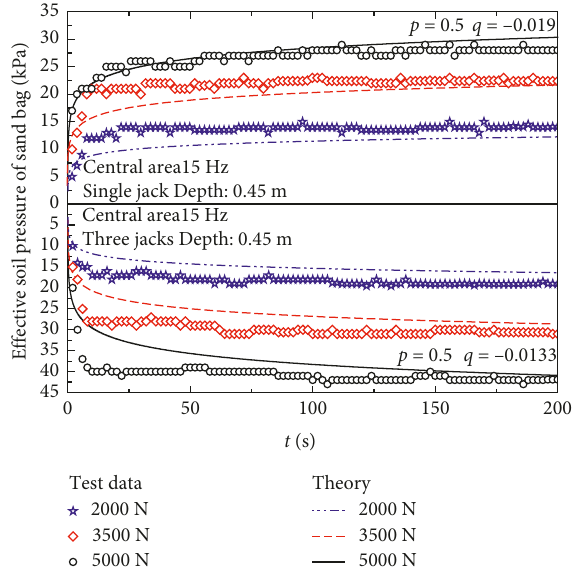
Figure 12: Variation in the effective soil pressure versus time curve under different excitation loads (sand